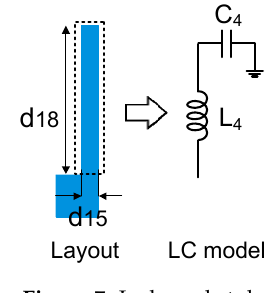
Figure 7. L-shaped stub.